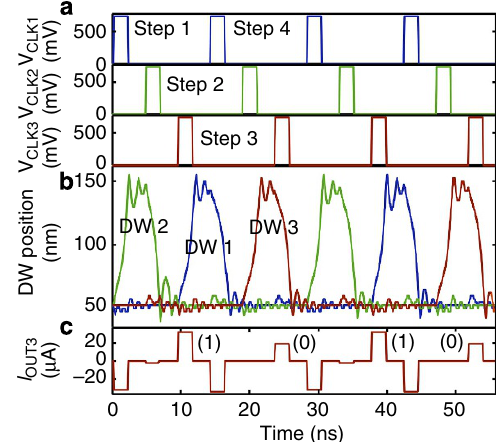
Figure 6 | Simulation of scaled three inverters circuit. Micromagnetic/ circuit simulation of transient behaviour predicted in a scaled-down device circuit with w ¼ 15nm and TMR ¼ 100%. ( a ) 0.7V, 2ns clock voltages for each device applied sequentially in time. ( b ) Simulation of the domain wall (DW) behaviour of each device, where we can see the DW switches between the left side of the device ( B 50nm) and the right ( B 150nm). Once the DW switches, it oscillates about its position. ( c ), Current at the I OUT3 node from Fig. 5a versus time. The positive current oscillates between bit 1 (32 m A) and bit 0 (19 m A). The negative current is from current flowing back from subsequent clock pulses, but it does not disturb the DW position in device